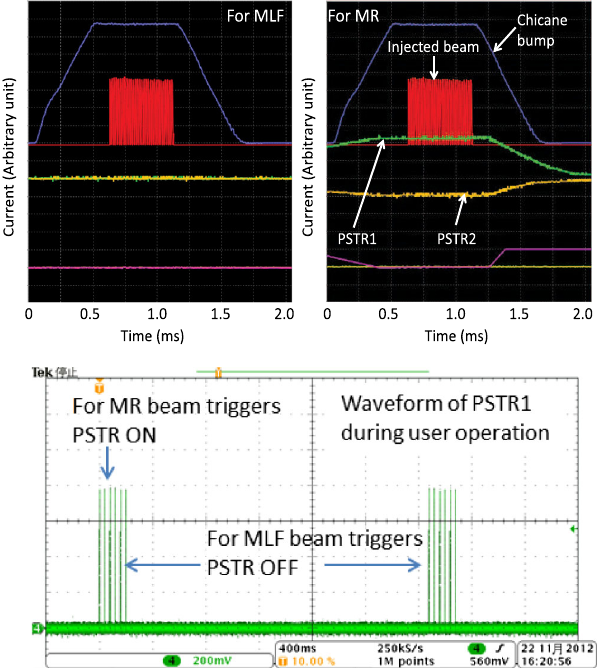
FIG. 9. Waveform of the PSTR magnets together with chicane bump magnet while in operation. They were found to be working as